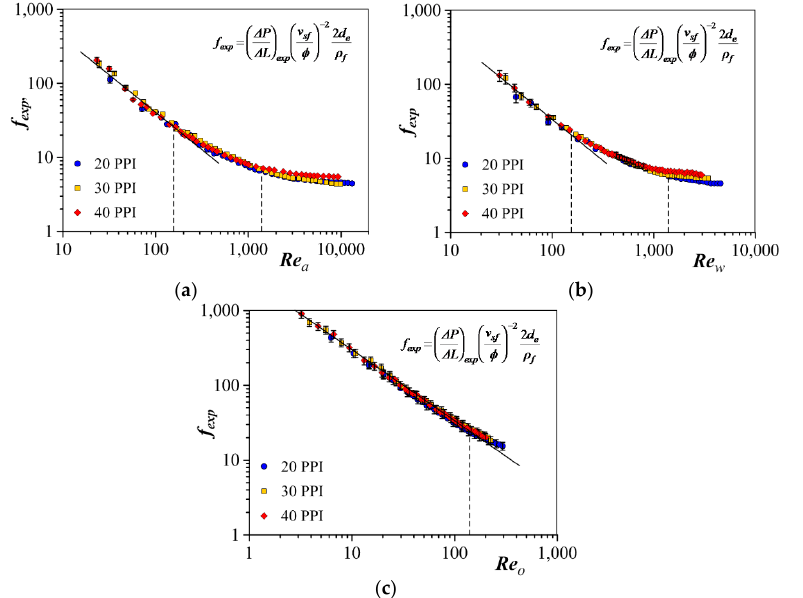
Figure 6. Change in the friction factor determined from measured pressure drop as a function of Reynolds number: ( a ) air flow; ( b ) water flow; ( c ) oil flow. (The uncertainty for friction factor was determined using Equation (A2)—Appendix A).